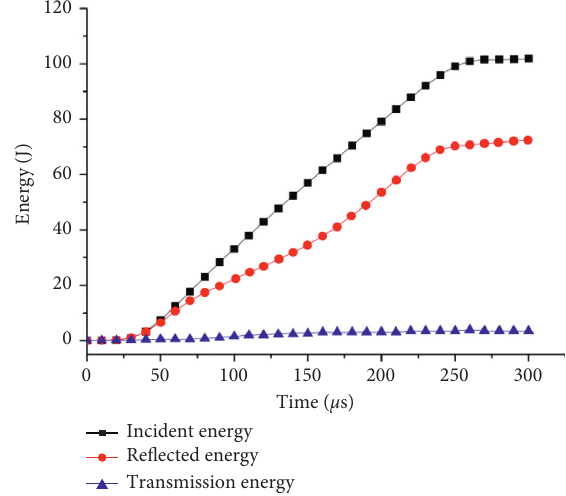
Figure 10: Energy evolution of sandstone with upper limit of cyclic load 0.4 σ b .